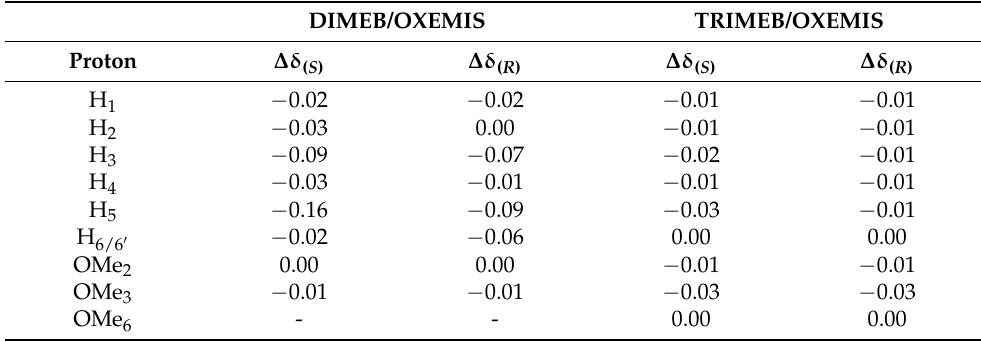
ppm) of cyclodextrin protons (12 mM) in the presence of OXEMIS (6